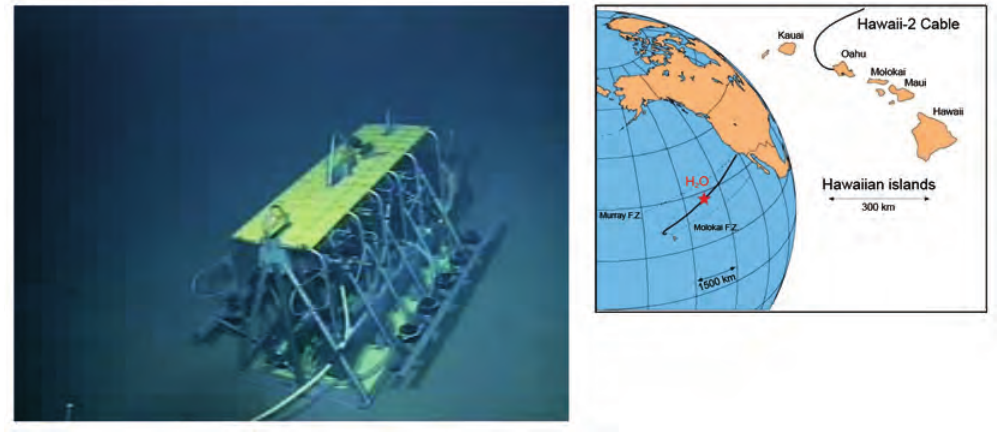
Fig. 4. The H2O junction box (on the left). A map of the H2O location and the route of the retired cable used is shown on the right (Chave et al. ,